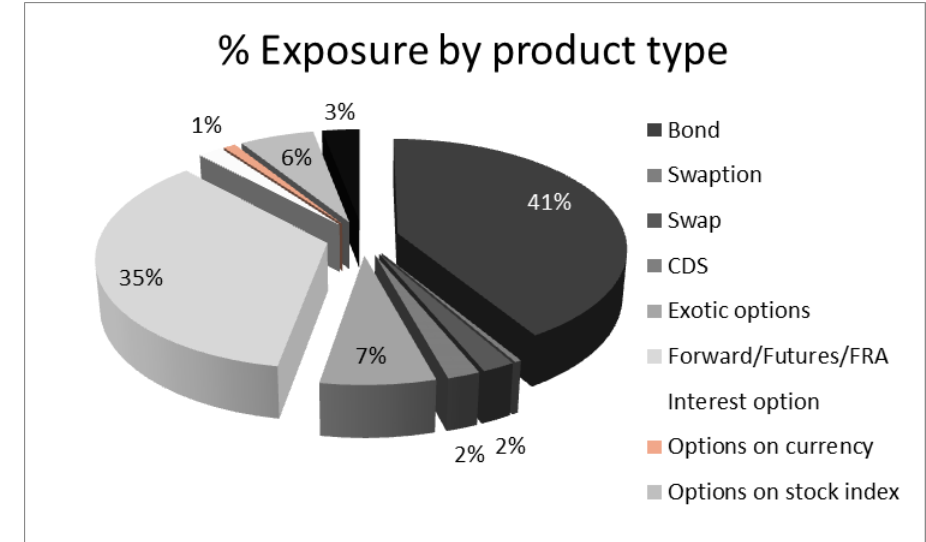
Figure 5. Composition of the trading book portfolio of Banca Intesa/SanPaolo 2015.